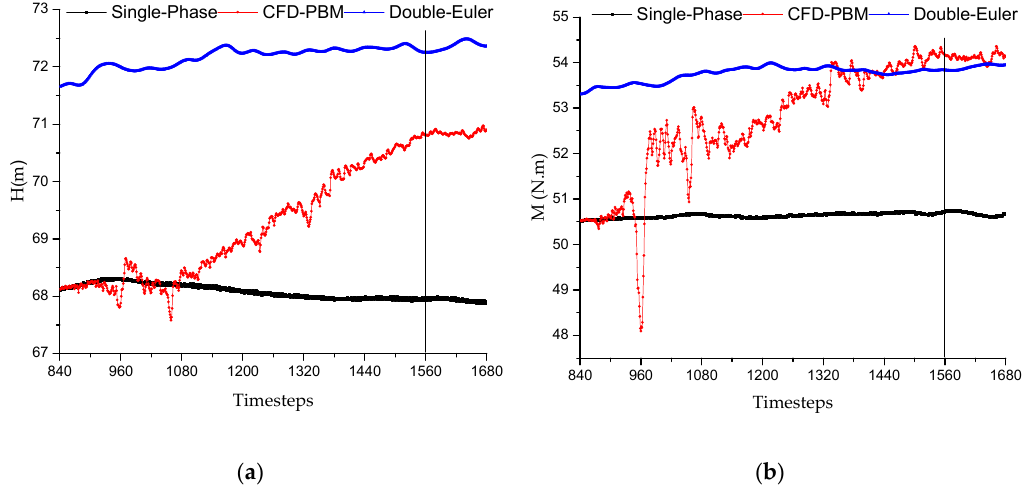
Figure 4. Head and torque fluctuation under 1.0 Q. ( a ) head; ( b ) torque.